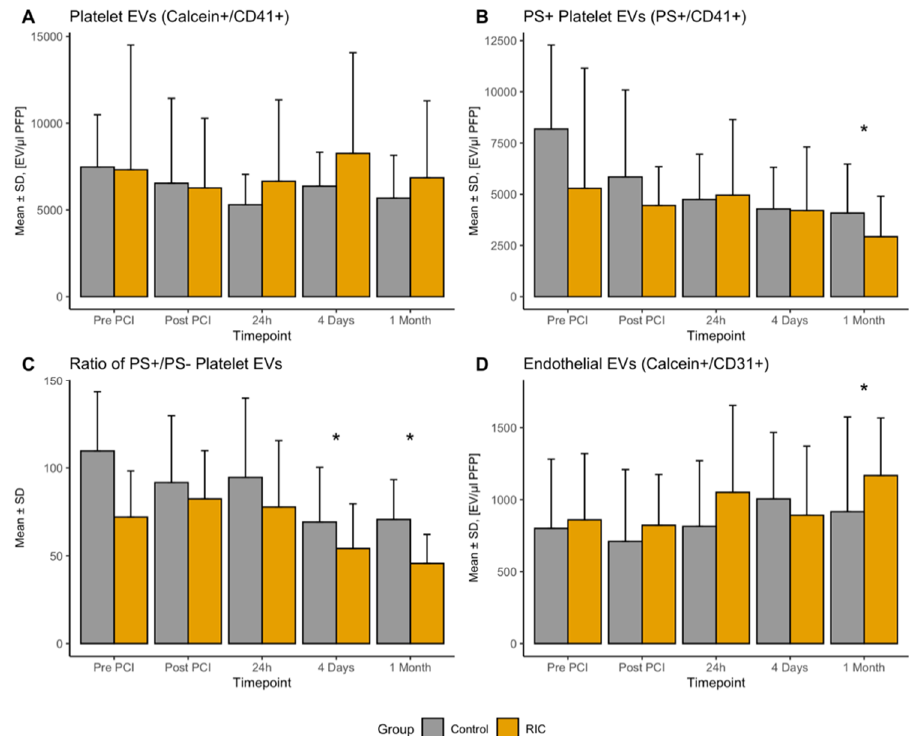
Figure 2. Number of circulating platelet-derived and endothelial EVs stratified by remote ischemic conditioning at all investigated times. ( A ) Provides results of all platelet-derived EVs, whereas ( B ) provided results for all pro-coagulatory platelet-derived EVs, which also express PS on their surface and their ratio is provided in ( C ). Endothelial EVs are provided in ( D ). All results are presented as mean ± standard deviation. * Marks statistically significant results at the specific time compared to “Pre PCI” derived from mixed-models. EV—extracellular vesicle; PCI—percutaneous coronary intervention; PS—phosphatidylserine; RIC—remote ischemic.